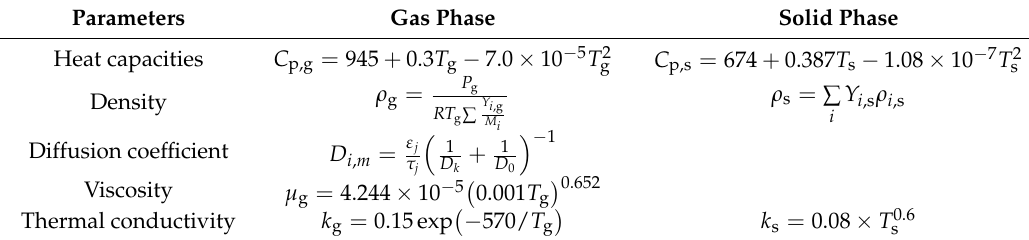
Table 2. Empirical formulae of thermo-physical parameters.